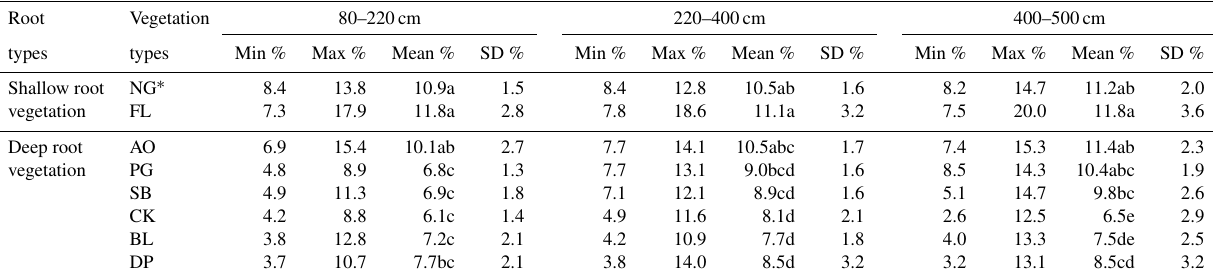
Figure 5. Profile distribution of DSM for different vegetation types: (a) shallow root system vegetation (NG – native grass; FL – farmland) and (b) deep root system vegetation (PG – pasture grasses; CK – Caragana korshinskii ; SB – sea buckthorn; DP – David peach; BL – black locust; AO – apple orchard). The error bars indicate the standard deviation. I–III: DSM at different soil layer depth ranges (I: 80–220cm, II: 220–400cm, and III: 400–500cm). The dashed lines are the boundaries of different soil layer depth ranges. Table 4. Deep soil moisture of the 80–500cm soil layers for different vegetation